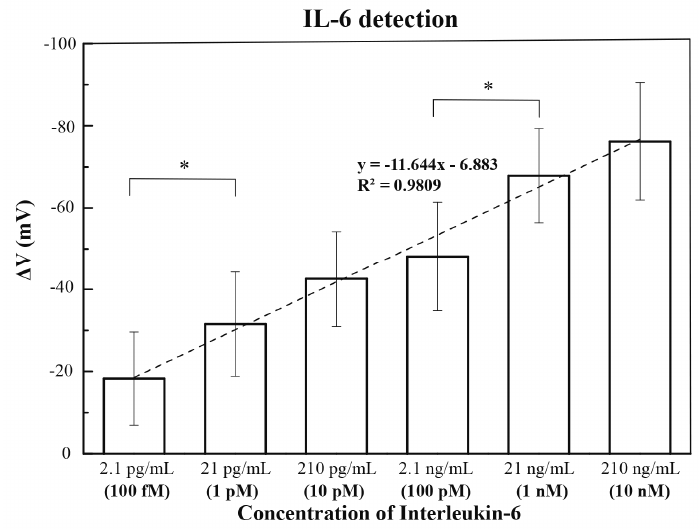
Figure 6. Detection of IL-6 on the SiNW-FETs with the mSAMs-GA-Apt layer. The average values of gate voltages and standard deviations for the 6 IL-6 concentrations from 100 fM to 10 nM are − 18.2 ± 11.4, − 31.5 ± 12.7, − 42.6 ± 11.6, − 48.1 ± 13.3, − 67.9 ± 11.5, and − 76.2, ± 14.3 mV, respectively. The asterisk symbols denote the significantly statistical difference between two adjacent groups ( p < 0.05).